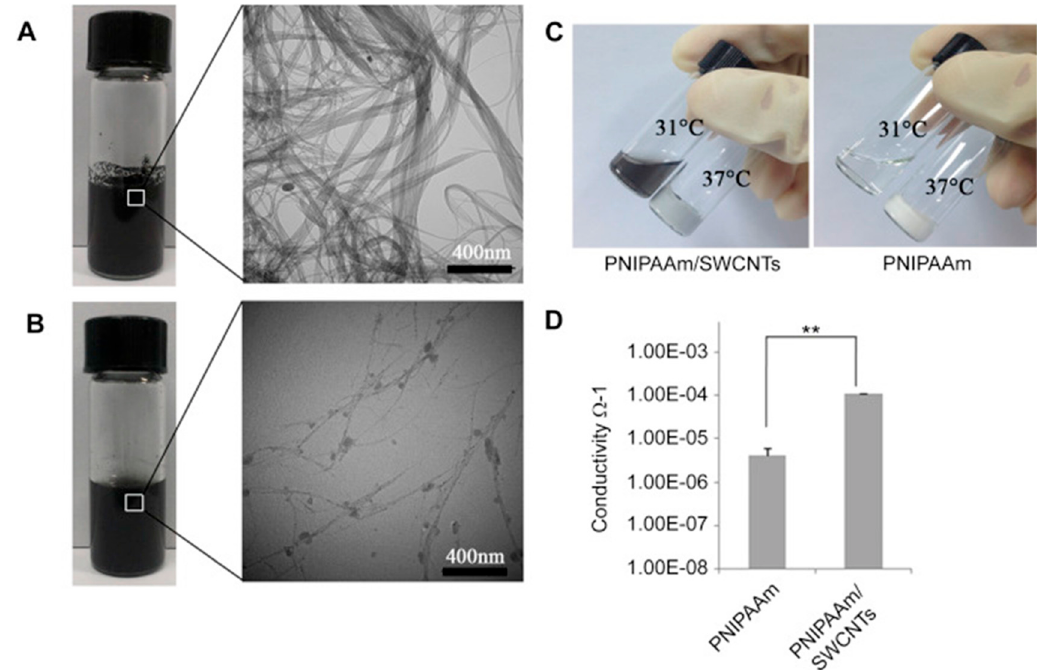
Figure 23. ( A – C ) Macroscopic and microscopic images of PNIPAAm and PNIPAAm/SWCNTs hydrogels, ( D ) comparison of conductivities values of both materials, PNIPAAm and PNIPAAm/SWCNTs hydrogels, upon gelation. Reprinted with permission from Reference [43]. Copyright from © 2014 Elsevier Ltd. (Amsterdam, The Netherlands).